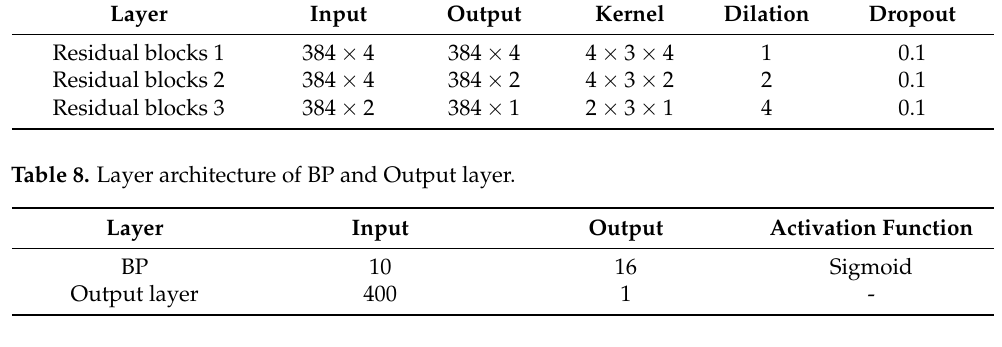
Table 9. Input variables